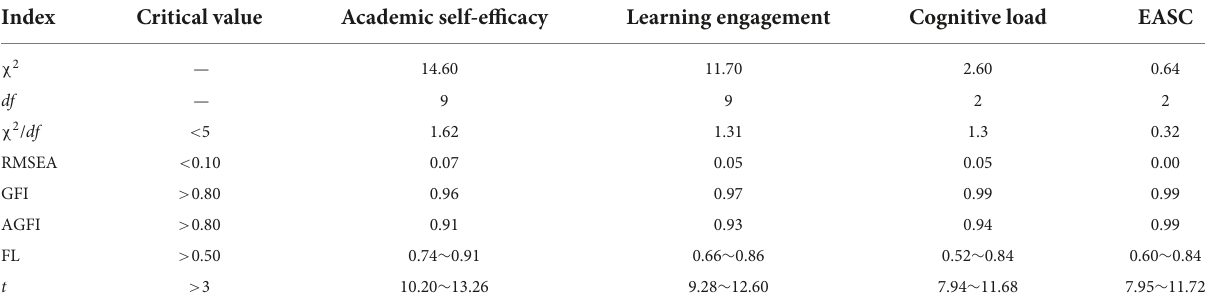
TABLE 1 First-order confirmatory